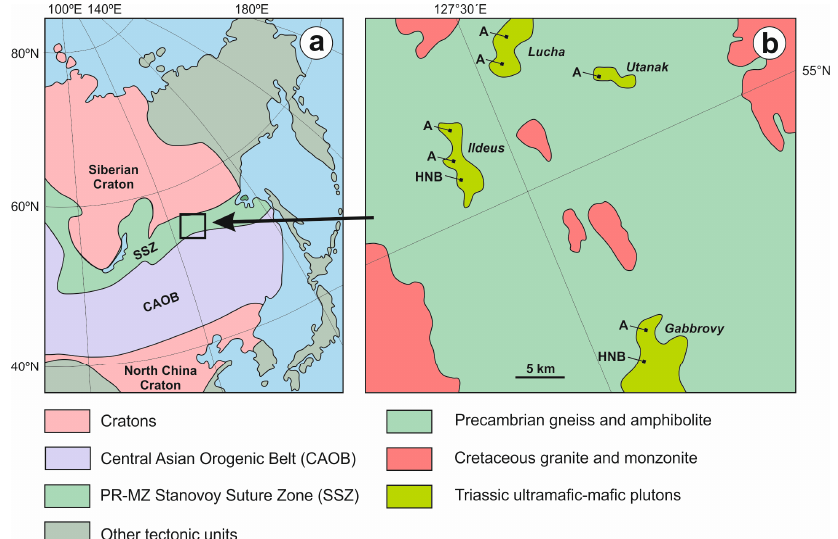
Figure 8. ( a ) Regional tectonic scheme showing position of Stanovoy Suture Zone (SSZ) in reference to Precambrian cratons, major orogenic belts (CAOB) and other tectonic units and ( b ) simplified geologic map of the central portion of the SSZ. Both maps are modified from [181]. A—adakite dikes, HNB—high-Nb basalt and lamprophyre